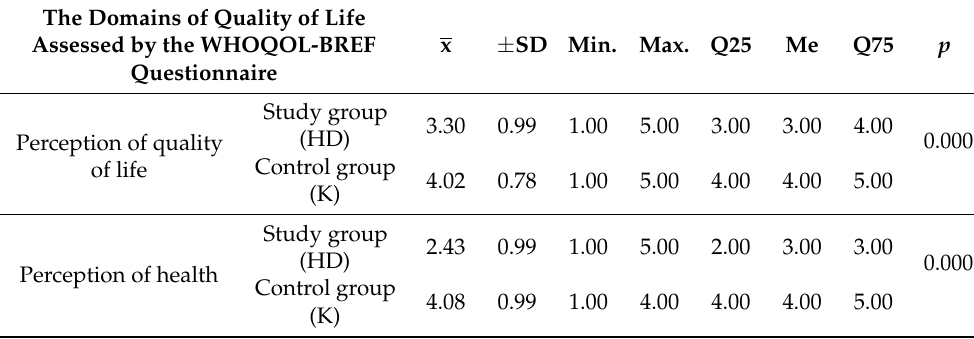
Table 2. Comparison of overall quality of life and health satisfaction assessed by the WHOQOL-BREF quality-of-life questionnaire in the study groups (HD, K).